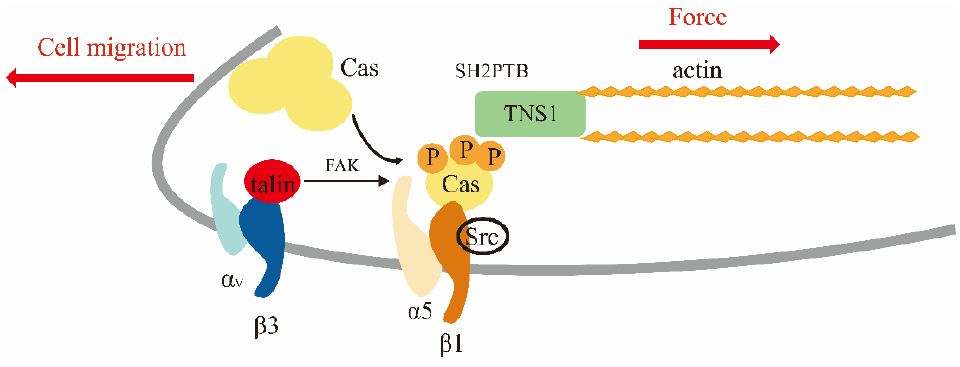
Figure 2. A model of the actin-Cas linkage.